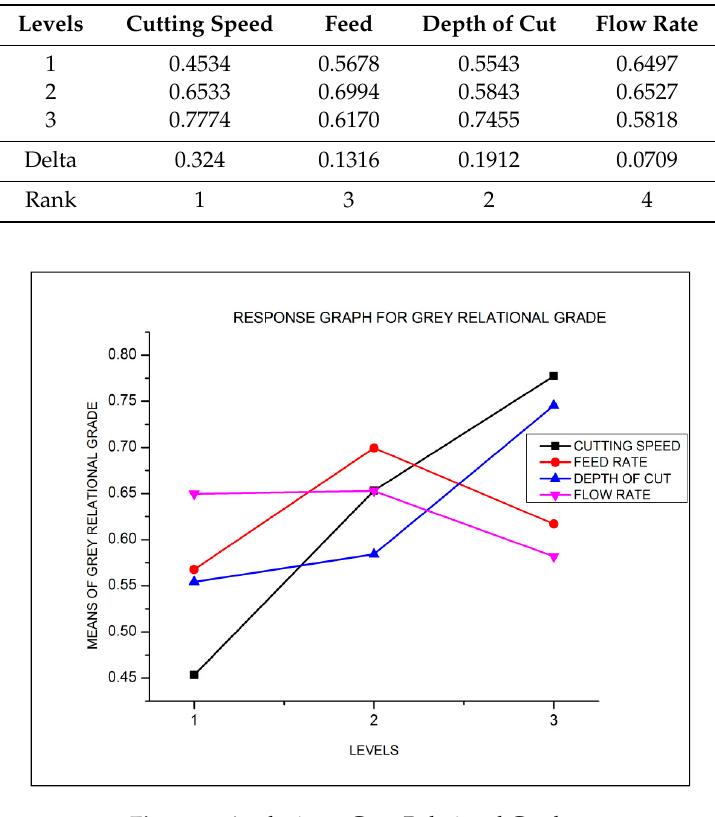
Figure 7. Interaction plot for material removal rate.